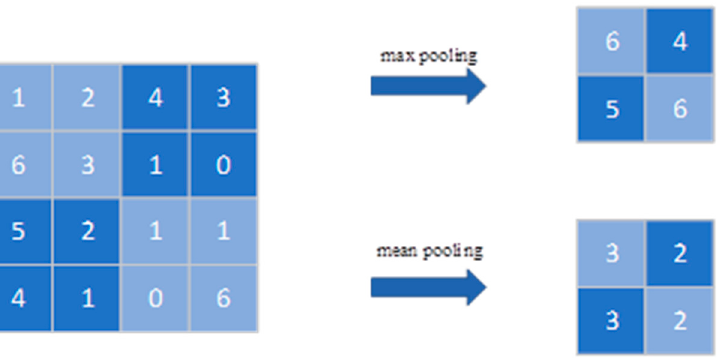
Figure 8. Max pooling and mean pooling.